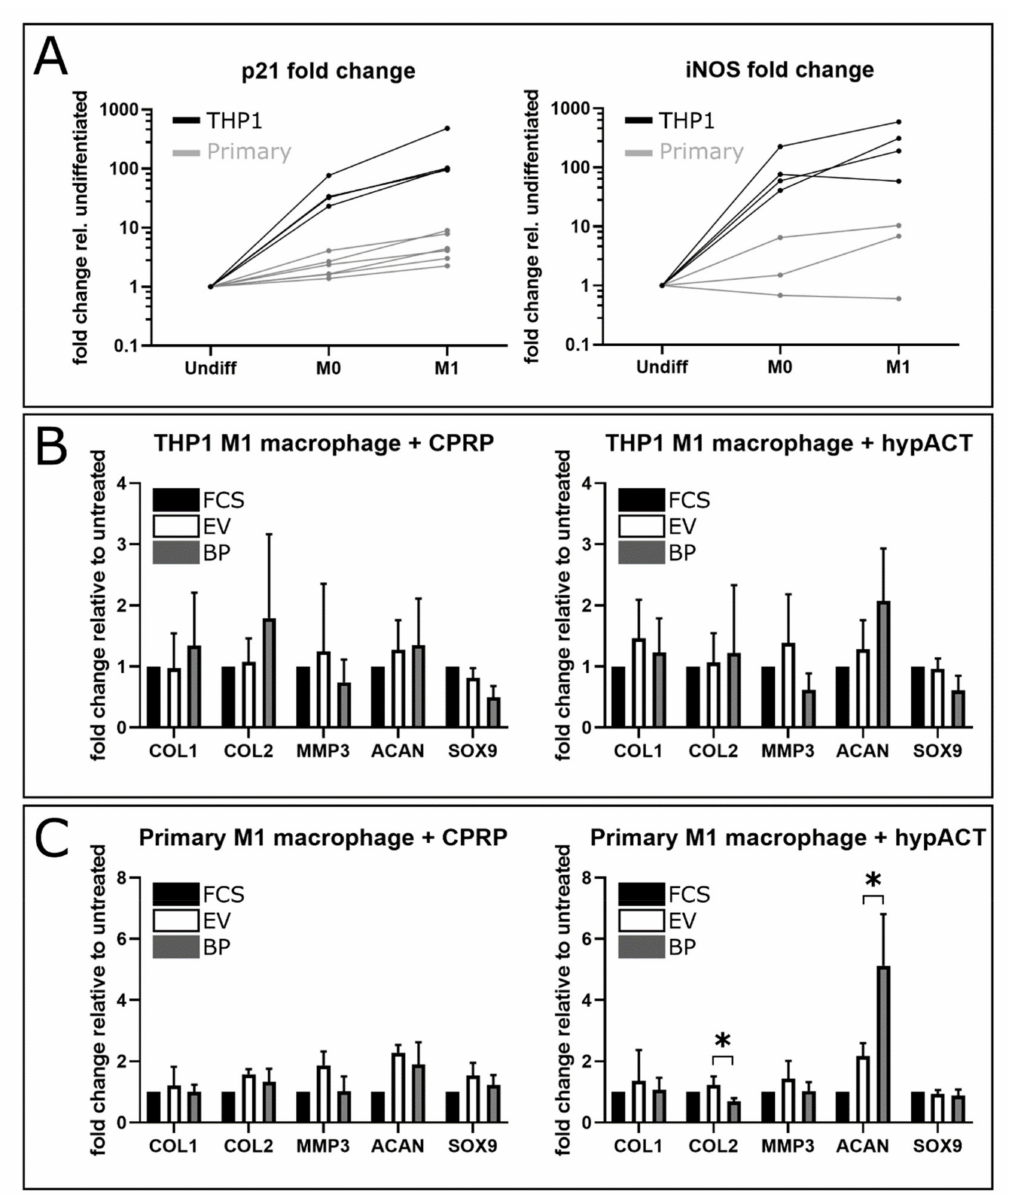
Figure 2. ( A ) Verification of macrophage activation via determining the increase in p21 and iNOS gene expression from undifferentiated monocytes to M1 macrophages. Data are given from 4 (THP1) or up to 6 (primary) experiments. iNOS fold change shows only 3 samples, because no iNOS was detected in undifferentiated primary monocytes from 3 donors. ( B , C ) Gene expression analysis of OA chondrocytes in co-culture with THP1 M1 macrophages ( B ) or primary M1 macrophages ( C ). Data are given as fold change normalized to FCS-supplemented co-cultures from 4 individual chondrocyte donors measured in triplicates ± SD. FCS: fetal calf serum supplementation; EV: supplementation with extracellular vesicles; BP: supplementation with blood products. *: p <